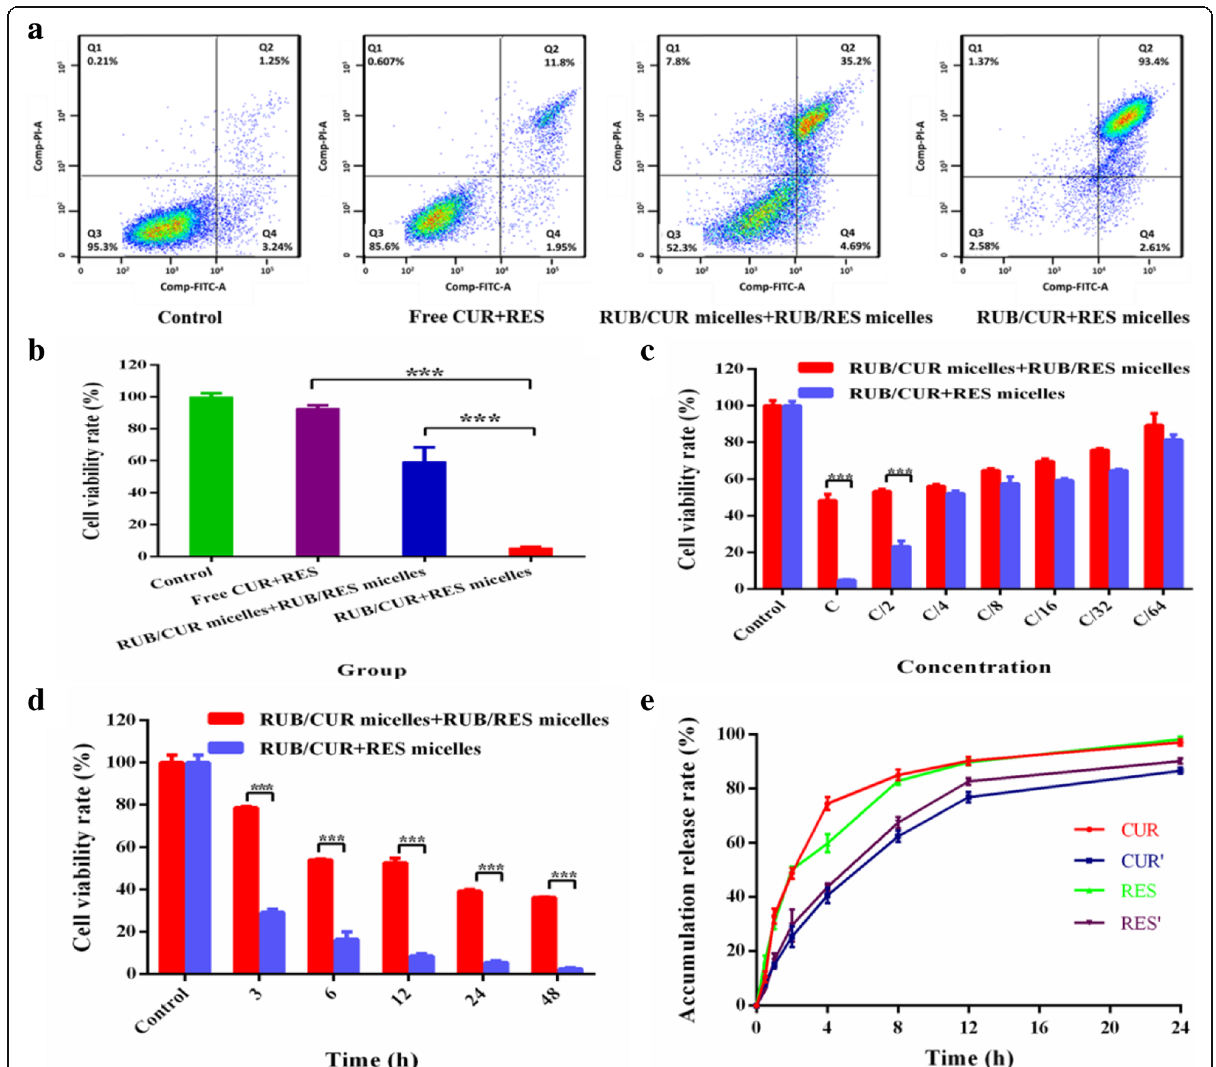
Fig. 6 The anti-cancer effects of RUB-based micelles on MCF-7 cells. a Apoptosis of MCF-7 cells treated with indicated formulations of CUR (23 μ M) and RES (110 μ M) for 24 h was analyzed by flow cytometry using Annexin V-FITC/PI staining. b Cell viability of MCF-7 cells was measured by MTT method, which was treated with indicated formulations of CUR (23 μ M) and RES (110 μ M) for 24 h. c , d Time- and dose-dependent manners of cell viability of MCF-7 cells treated with indicated formulations were measured by MTT method. c represented for CUR (23 μ M). RES ’ concentration was 110 μ M. e In vitro release profile of CUR and RES from RUB/CUR + RES micelles and RUB/CUR micelles + RUB/RES micelles in PBS buffer (pH 7.4). Error bars indicated s.d. ( n =3). *** P <0.001 (two-tailed Student ’ s t